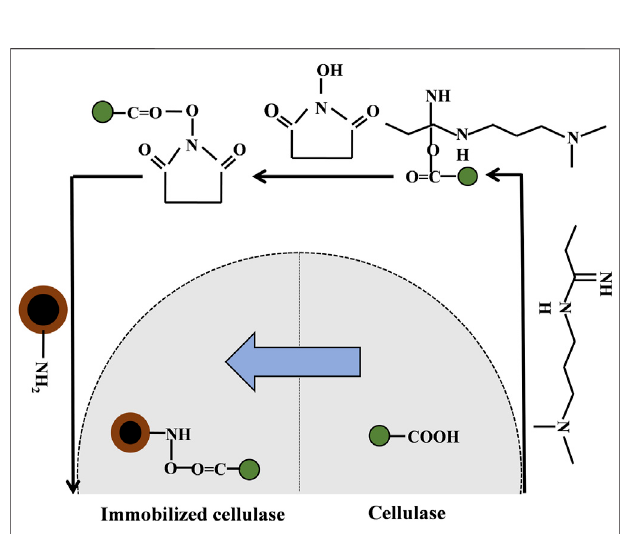
FIGURE 4 | The oriented immobilization process of cellulase on magnetic nanoparticles.